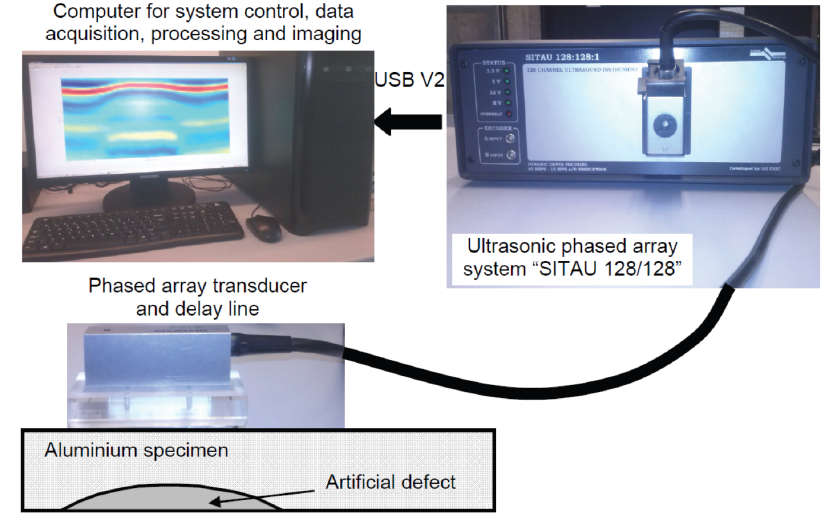
Figure 5. Images of the experimental setup.